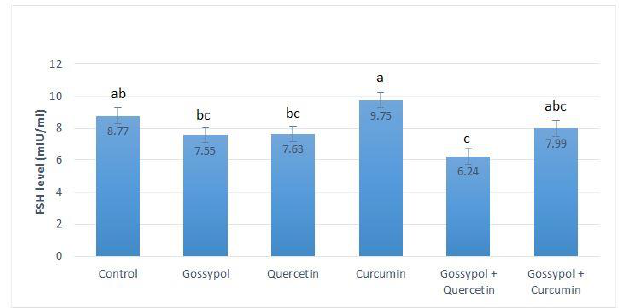
Fig. 3: The effect of treatment with gossypol, quercetin, curcumin, gossypol + quercetin and gossypol + curcumin on FSH level in serum (mean ± standard error). Similar letters indicate no significant differences between groups at (P > 0.05), while different letters indicate a significant difference between groups at (P < 0.05).